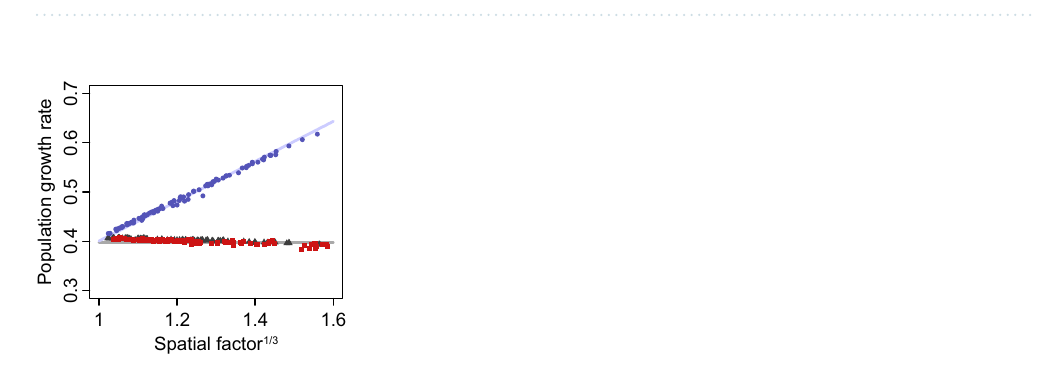
Figure 2. Effects of spatial heterogeneity of dispersal vectors on population dynamics as a function of model type. ( a ) Schematic describing three phases used; (i) establishment (0–5%, panel b ), (ii) expansion (5–95%, panel c ), and (iii) naturalization (95–100%, panel d ). ( b – d ) Response periods of phases based on the spatial factor. Points and corresponding vertical lines represent medians and 25%–75% quantiles of 100 realizations, respectively. Black triangles, red squares, and blue circles correspond to destination-mediated-dispersal, source- mediated-dispersal, and source–destination-mediated-dispersal models, respectively. Black open circles and lines on the left point (spatial factor F h = 1 ) correspond to a null model without any spatial heterogeneities.